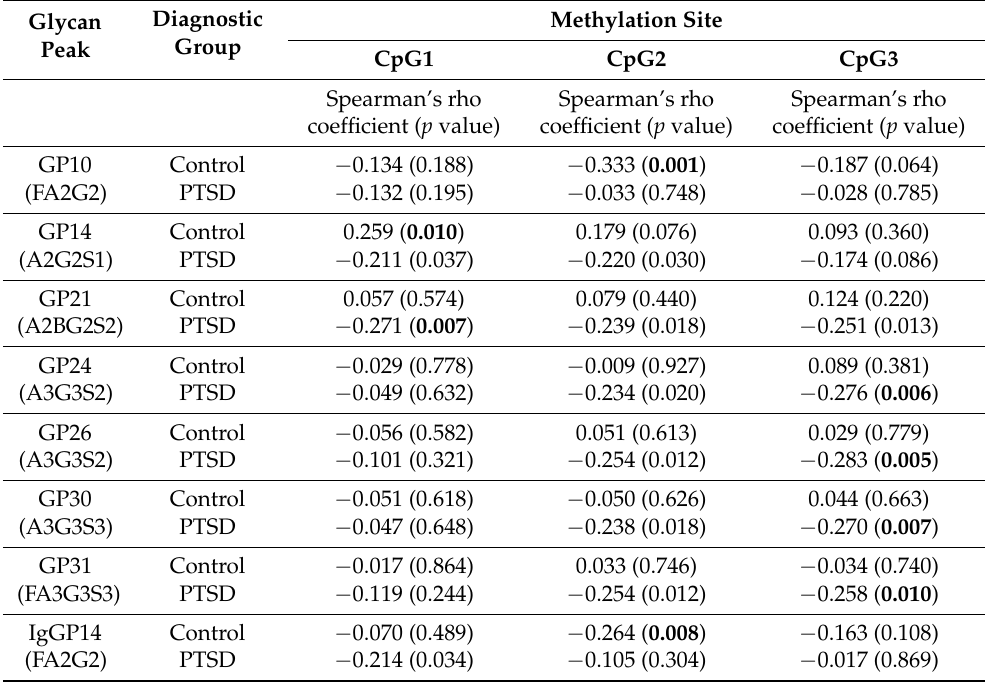
Table 3. Correlations between methylation at 3 CpG sites of the HNF1A gene and the plasma and IgG N-glycan